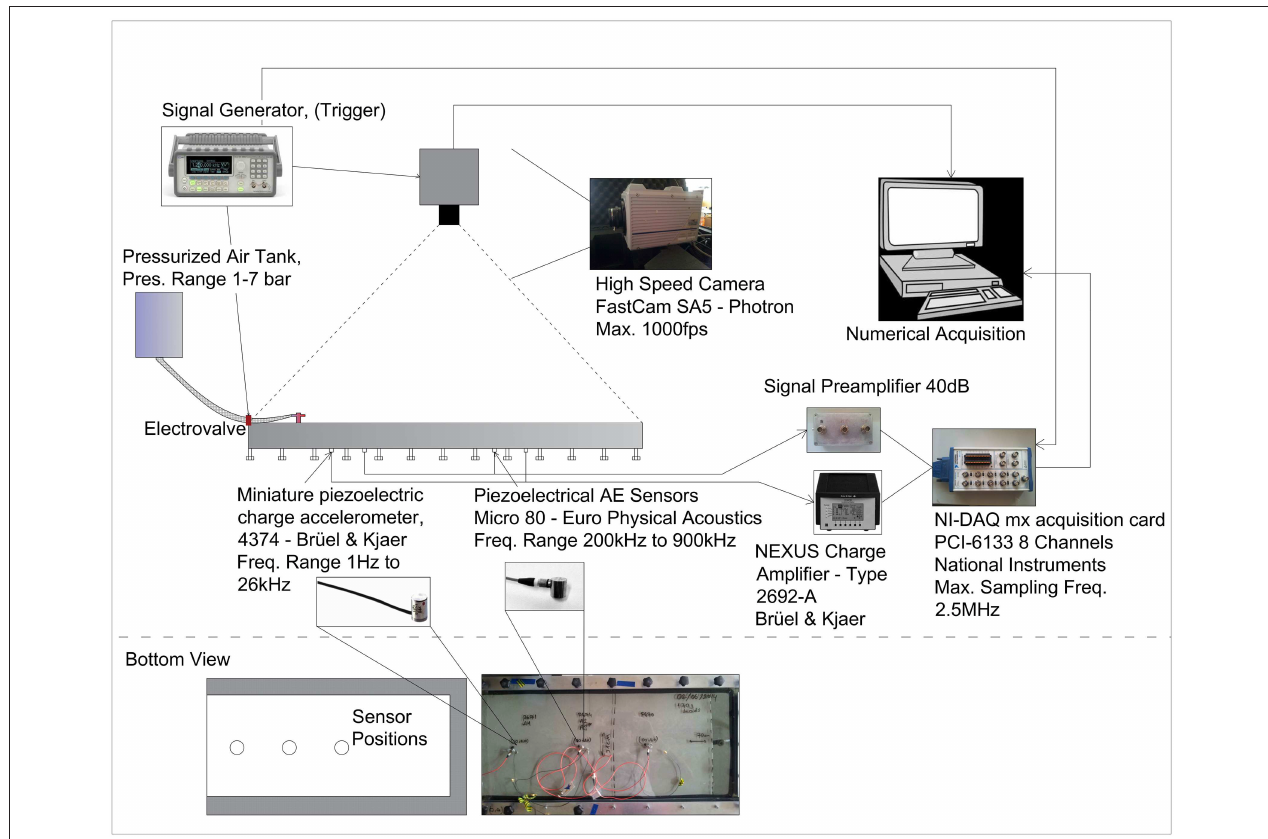
FIGURE 2 | The acquisition chain of the aero-fracturing experiments with a Hele-Shaw cell. The signal acquisition card, camera and the electrovalve connected to the air pump are triggered at the same time via a TTL sent from the signal generator to have synchronized optical and acoustic data. The sensors are placed on the bottom glass plate of the Hele-Shaw